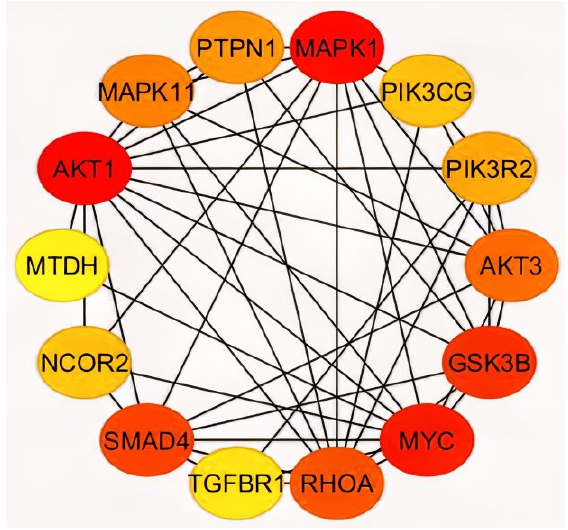
Figure 7. Major hub genes of miR-122; identification of hub genes through Cytohubba plugin in Cytoscape 3.8.0 software. The rank of connection degree is represented by the different degree of colors (from red to yellow).